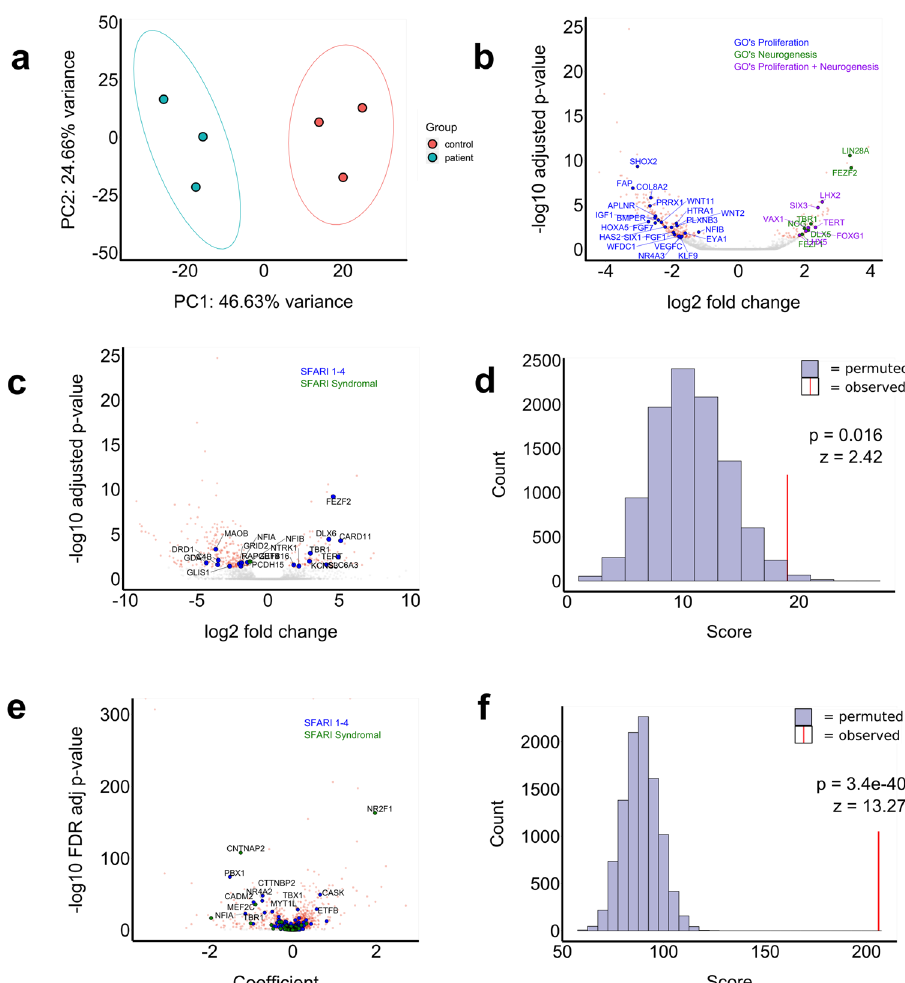
Fig. 4 Differentially expressed genes are enriched for GOs related to cell proliferation and neurogenesis, as well as ASD-associated genes. a Principal component analysis shows a clear distinction between the expression pro fi les of patient-compared to control-derived organoids at 8 weeks in vitro. b Volcano plot showing differentially expressed genes between patient- and control-derived organoids at 8 weeks in vitro. Genes reaching statistical signi fi cance are colored in red, and genes below statistical signi fi cance threshold are colored in gray. A total of 250 genes are downregulated while 89 are upregulated. Genes are highlighted according to their Gene Ontology (GO). GOs related to cell proliferation (blue) (GO:0050673, GO:0050678, GO:0010463, GO:0010464, GO:0050679), neurogenesis (green) and both proliferation and neurogenesis (purple) (GO:2000177, GO:0072091, GO:0061351, GO:1902692, GO:0072089, GO:2000179, GO:0007405, GO:0050768, GO:005076). c , d The same volcano plot shown in panel b , but now with ASD-associated genes curated by SFARI enriched among the DE genes highlighted. Blue dots are genes in SFARI categories 1 – 4, green dots are in category ‘ syndromic ’ ( c ). Statistical signi fi cance was tested using a permutation test ( n = 10,000) showing an enrichment higher than enrichment expected from random events ( z = 3.28, p = 0.001). e , f Volcano plot showing genes that are differentially expressed in three CNTNAP2 -expressing cell types (EN-V1, EN-PFC, and nEN). Genes reaching statistical signi fi cance are colored in red, and genes below statistical signi fi cance threshold are colored in gray. Blue dots are genes in SFARI categories 1 – 4, green dots are in category ‘ syndromic. Of 2800 differentially expressed genes in these cell types, 215 are present in the SFARI database ( e ). Enrichment for SFARI genes at the single-cell level was more pronounced than in the bulk RNA sequencing analysis as indicated by the bar plot displaying the permutation analysis ( n = 100,000, z = 13.93, p =